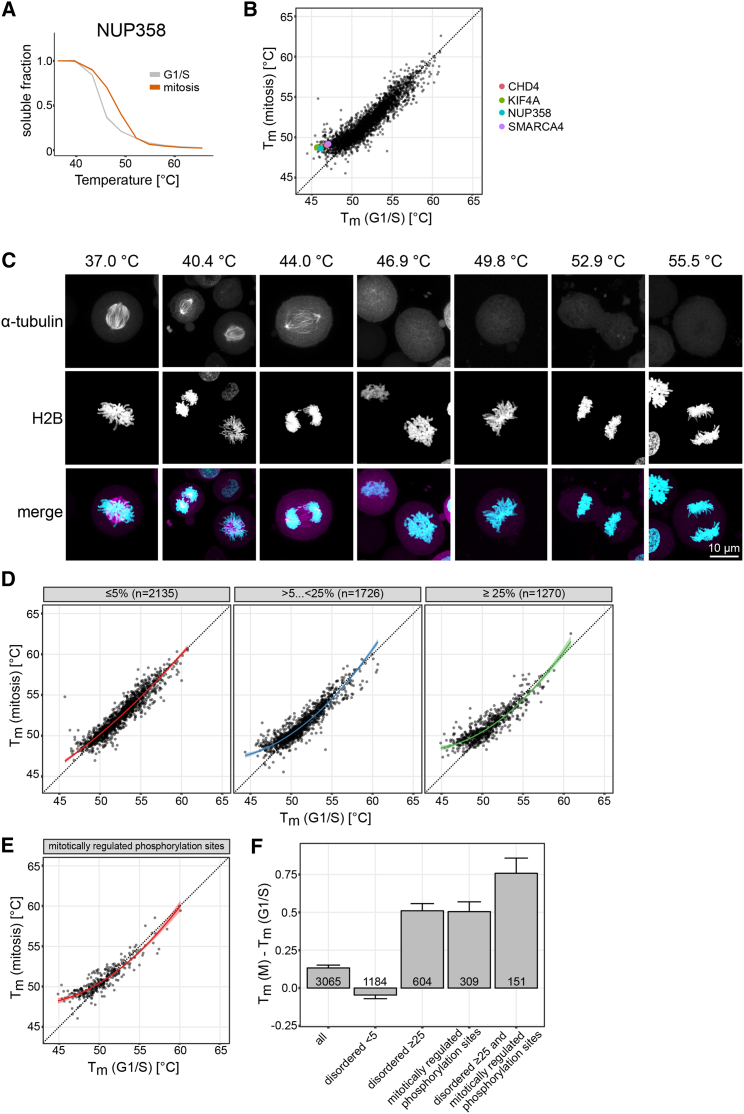
Disordered, Mitotically Phosphorylated Proteins Are Stabilized during Mitosis(A) Melting curves of NUP358 in G1/S and mitosis. Data represent three biological replicates.(B) Scatterplot comparing the melting temperatures (Tm) for proteins in G1/S (x axis) and M (y axis). A shift toward higher melting points in mitosis for representative proteins CHD4, KIF4A, NUP358, and SMARCA4 are indicated with coloring.(C) Microscopy images of the mitotic spindle at different temperatures. Mitotic HeLa Kyoto EGFP-alpha-tubulin/H2B-mCherry cells were imaged after heat treatment. z stacks maximum intensity projections of samples treated at the indicated temperatures are shown. On the merged images, α-tubulin and H2B are shown in magenta and cyan, respectively.(D) Scatterplots illustrate the melting point shift observed from G1/S (x axis) to M (y axis) at different cutoffs for the relative coverage of disordered regions (indicated above each plot as a percentage).(E) Shift of melting point for proteins containing mitotically regulated phosphorylation sites as described in Olsen et al. (2010).(F) Melting point difference for proteins with different levels of disordered regions in their sequence and containing mitotic phosphorylation sites. SEM is shown.See also Figure S6 and Tables S4 and S6.